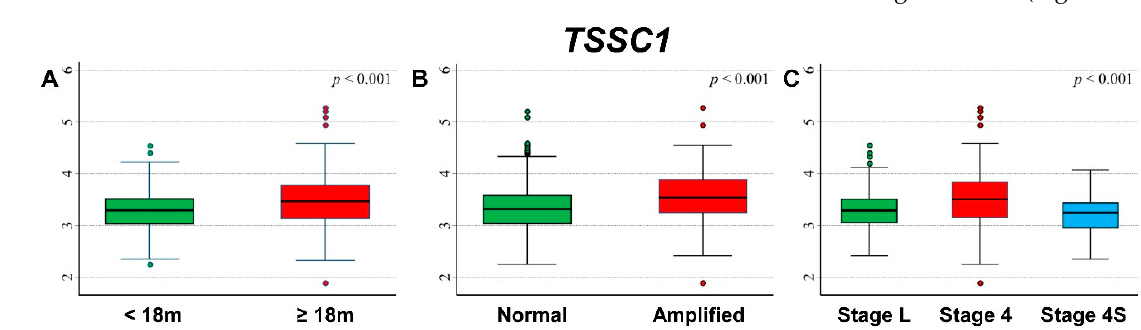
Figure 6. Association between TSSC1 gene expression and the main patient characteristics at diagnosis. ( A ) Age; ( B ) MYCN status; ( C ) Stage.